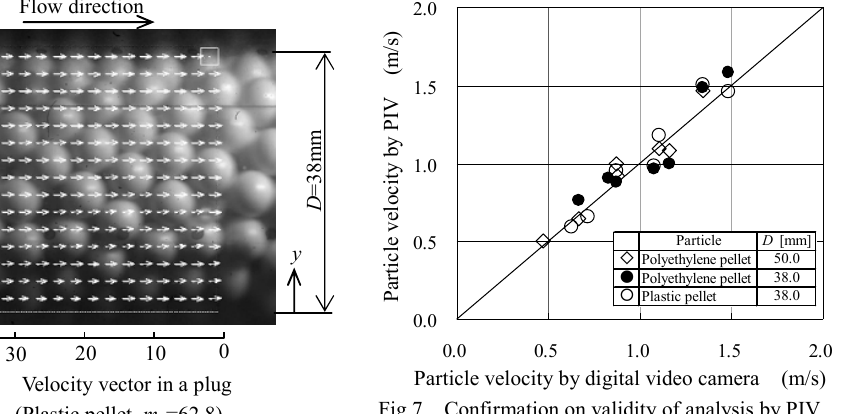
Fig.7 Confirmation on validity of analysis by PIV Stationary bed PlugExternal plug